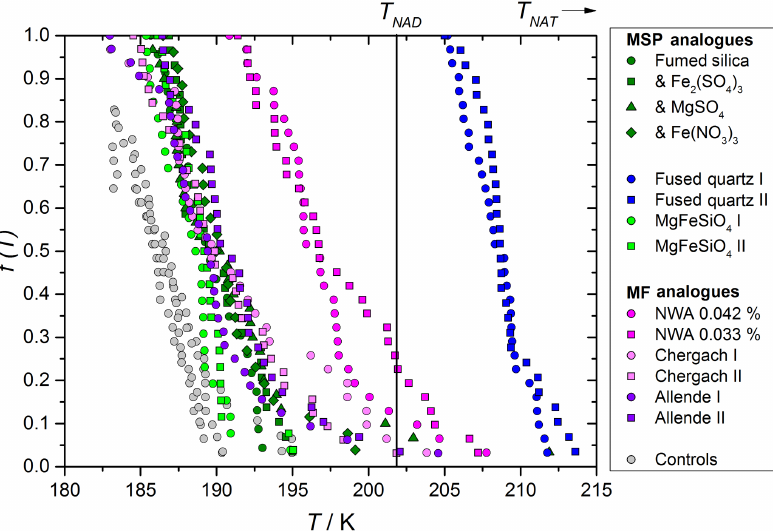
Figure 3. Fraction of droplets crystallized at different temperatures, showing a heterogeneous effect for a variety of analogues for MSPs and MFs. Experiments were carried out using particulate solids suspended in 39.94 ± 0.08wt% HNO 3 in H 2 O. MSP analogues are shown in blue and green colours and were suspended to concentrations of 2.512 ± 0.019wt%, MF analogues are shown in pink and red colours and were suspended in concentrations of 0.043 ± 0.002wt%, except where stated in the legend for the NWA meteorite. Repeat experiments, distinguished by roman numerals, are shown as different symbol shapes. Experiments with fumed silica labelled with metal salts contained 0.635 ± 0.005wt% of the relevant metal ion as well as fumed silica. The instrument background (when no heterogeneous material was added to the nitric acid solution) measured in four repeat experiments is shown as grey points. A vertical line is used to show the NAD melting point ( T NAD ) , whereas the NAT melting point ( T NAT ) was at